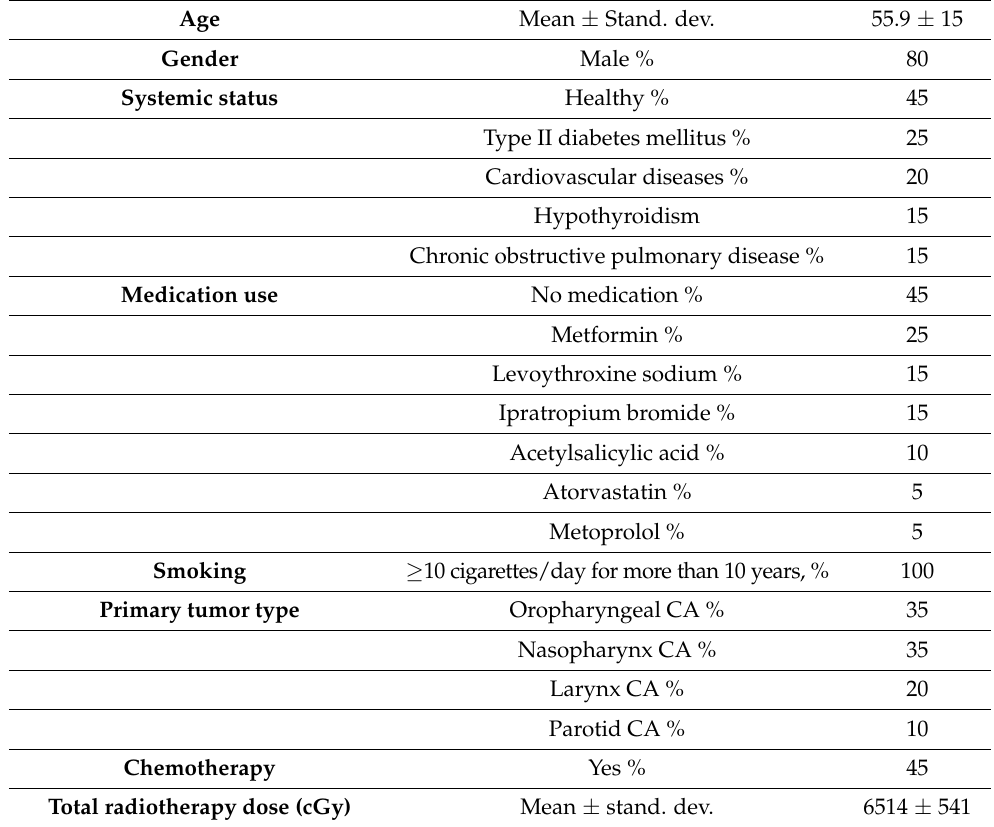
Table 1. General characteristics of the study population. Age Mean ± Stand.